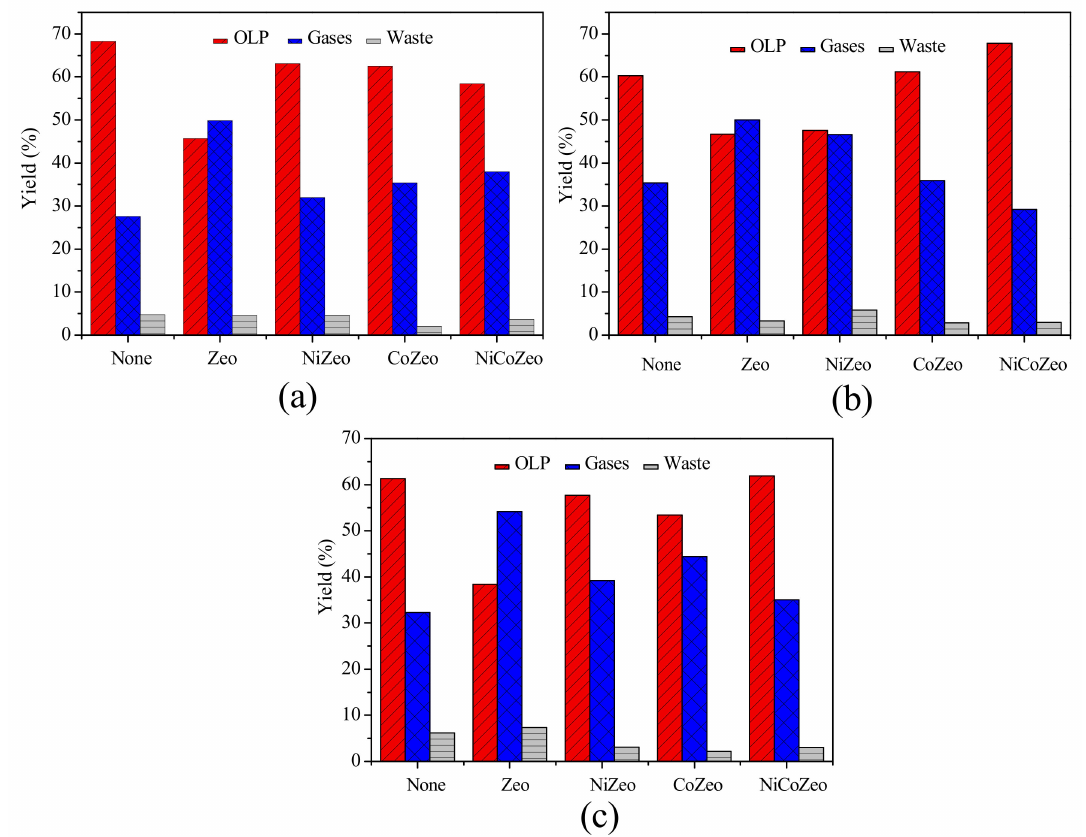
Figure 8. Yields to liquid, gaseous and solid products in DO reactions at different temperatures. ( a ) 250 ◦ C, ( b ) 300 ◦ C and ( c ) 350 ◦